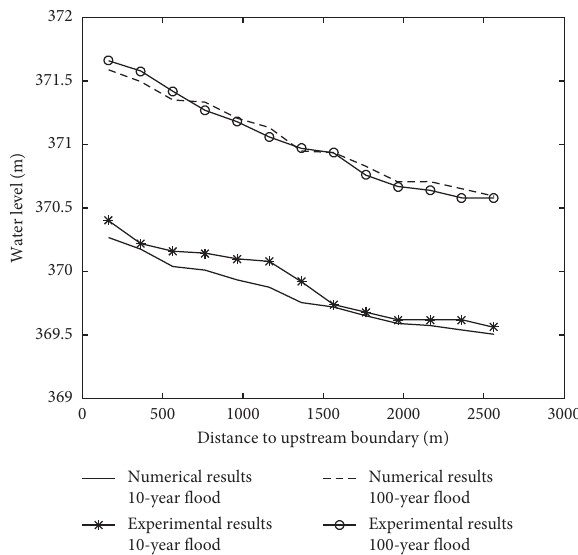
Figure 4: Comparison of longitudinal water level